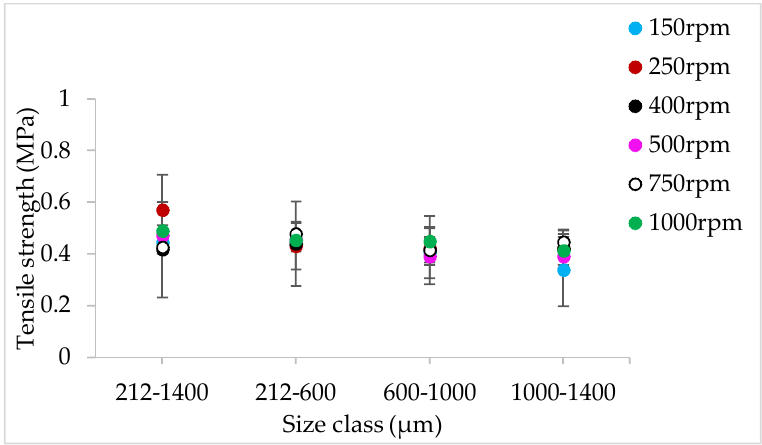
Figure 12. Tensile strength of tablets of lactose granules produced at varying screw speed at SFL—0.083 and PFN—3.42806 × 10 −5 (L/S 0.1).